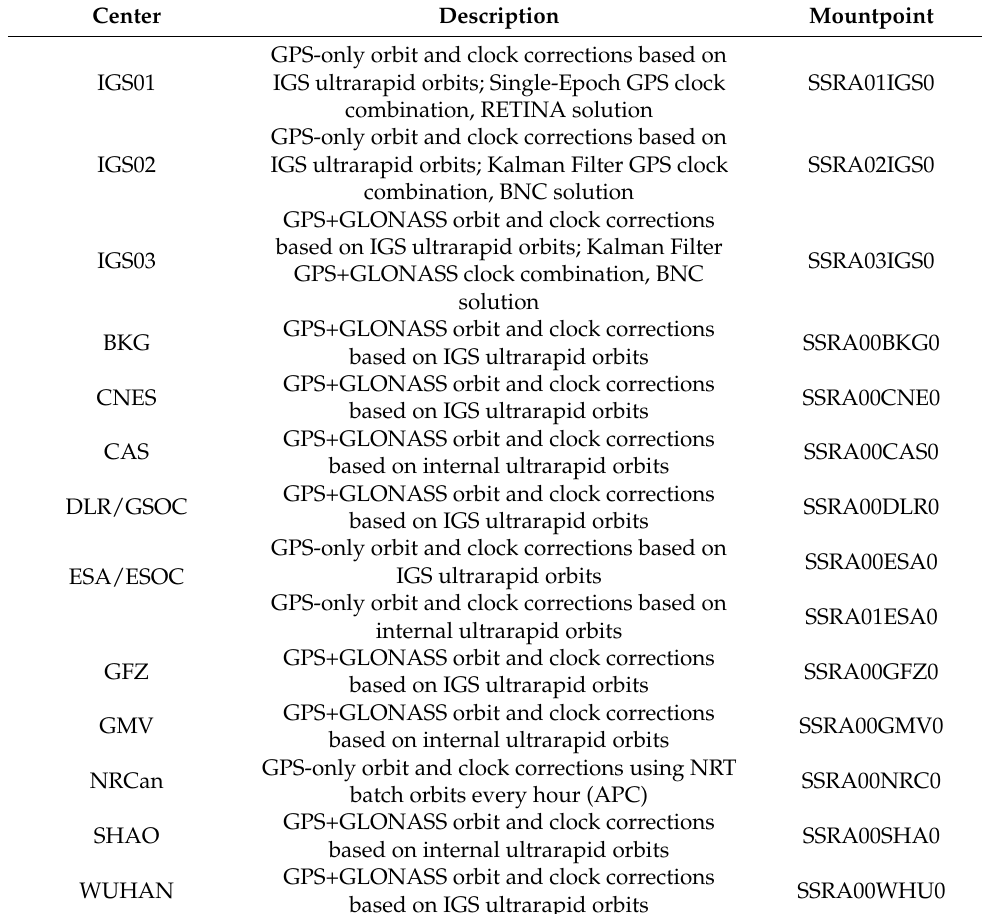
Table 2. Status of IGS RTS combinations and individual analysis center